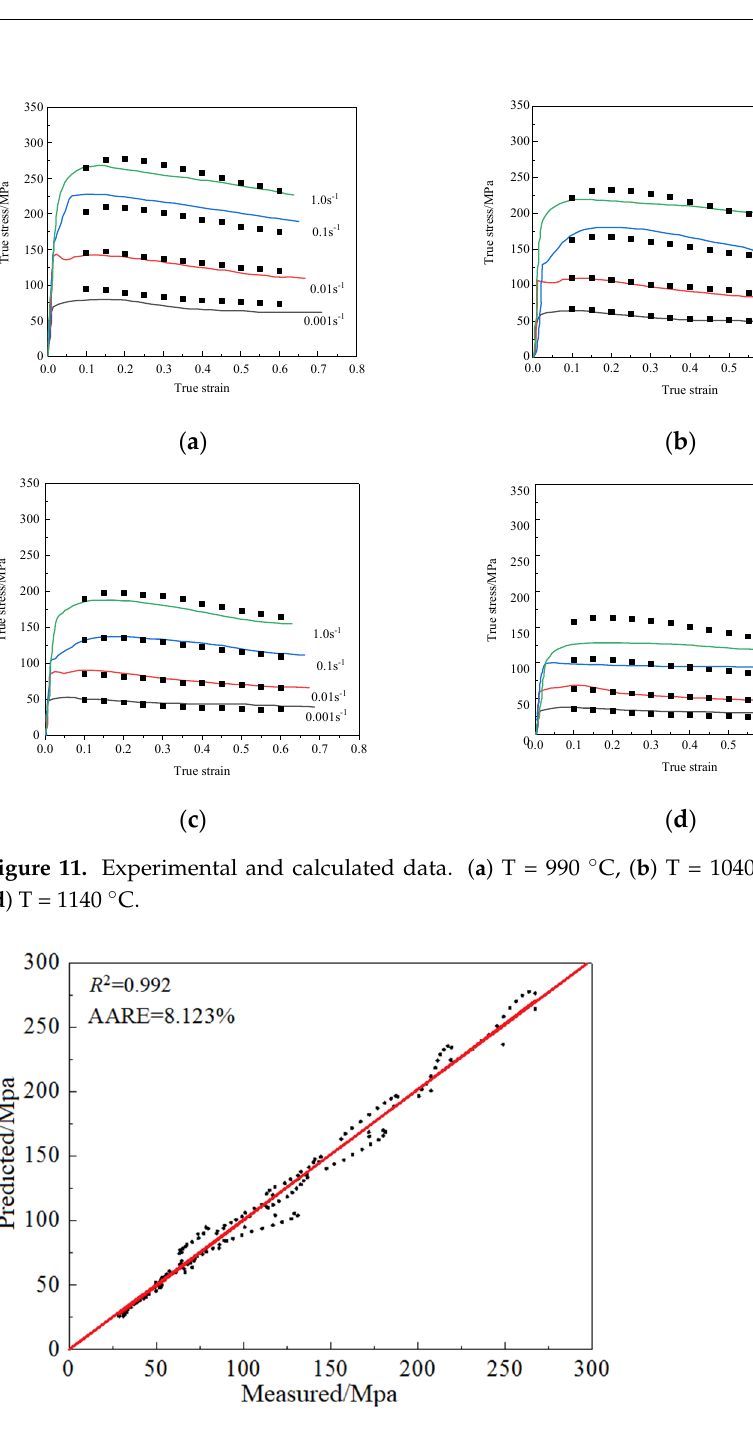
( d ) Figure 10. Polynomial relationship between material parameters and strain ( a ) α ( b ) n ( c ) Q ( d ) ln A . As can be seen from Figures 11 and 12, under different strains, the absolute value of the average relative error AARE (%) between the tested stress value and the predicted stress value was 8.123%, which was less than the acceptable error range of 10%. Mean-